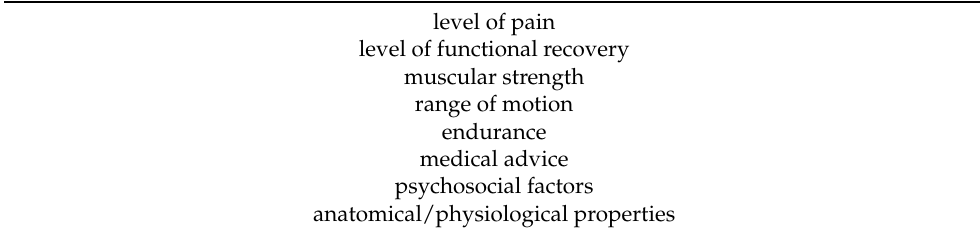
Table 2. Proposal of RTS criteria after Achilles tendinopathy